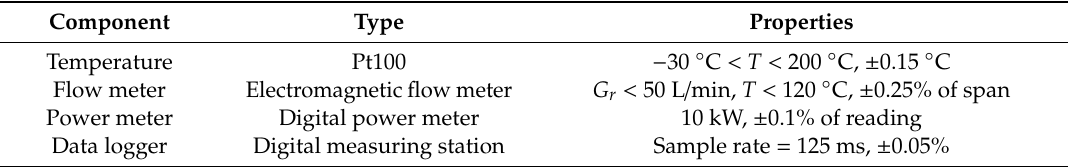
Table 3. Uncertainties of experimental